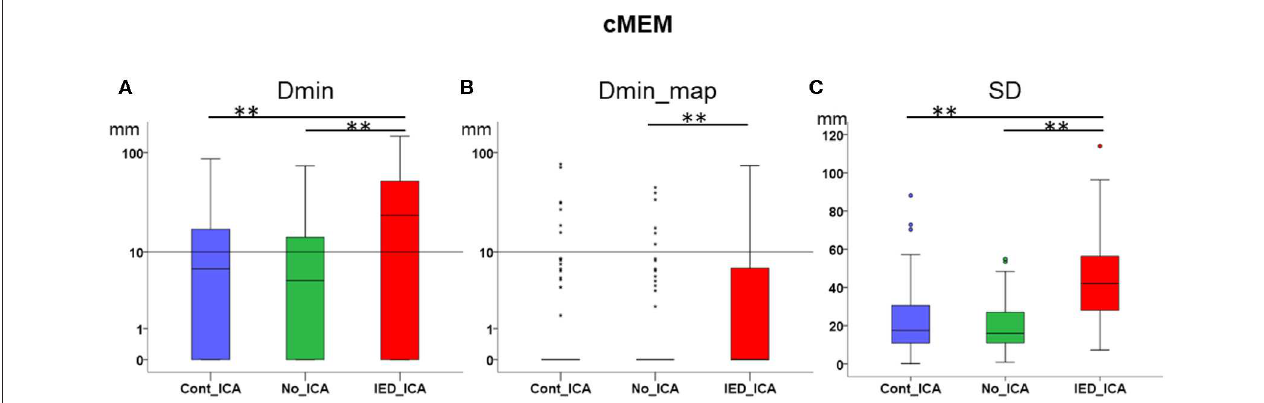
FIGURE 4 | Effect of ICA on cMEM. (A) Dmin was significantly lower (better) for No_ICA and Cont_ICA as compared to IED_ICA. (B) Dmin_map was significantly worse for IED_ICA as compared to No_ICA. (C) The spatial dispersion was significantly higher (worse) for IED_ICA as compared with No_ICA and Cont_ICA. ** p <